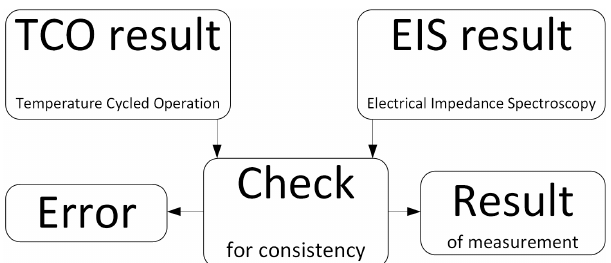
Figure 1. Scheme of the sensor self-test strategy (cf. Schüler et al.,